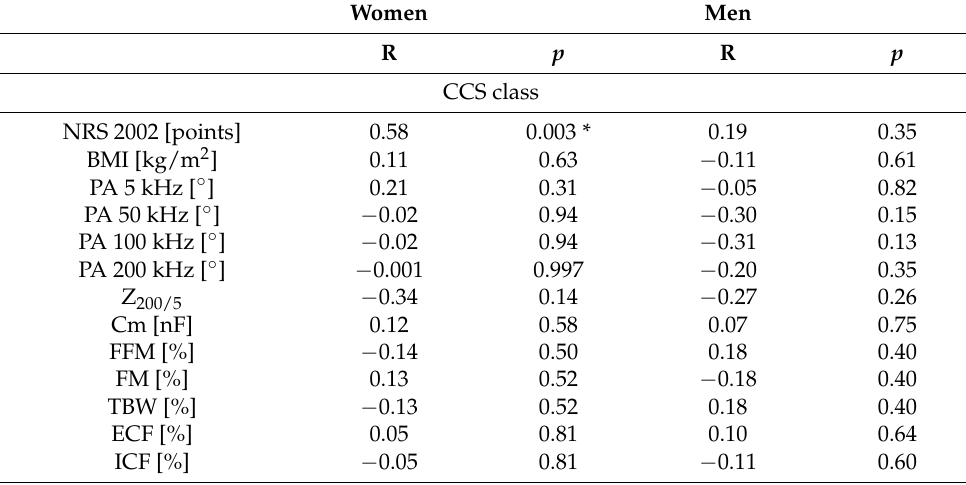
Table 5. Correlation between nutritional status and main CAD parameters in women and men